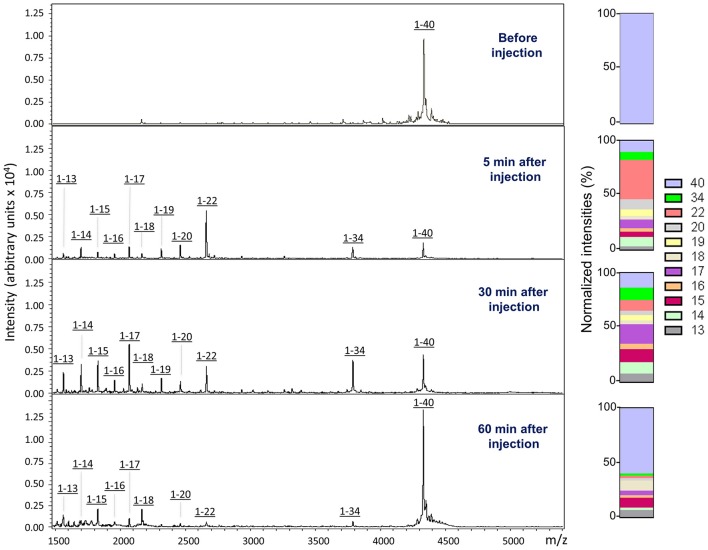
Aβ species cleared to the CSF assessed by a combination of immunoprecipitation and mass spectrometry. MALDI-ToF spectra and normalized ion counts of the monomeric Aβ1-40 used for the experiments prior injection (top). MS profile of the material immunoprecipitated from CSF at different time points (5, 30, and 60 min) post injection identify multiple C-terminally degraded proteolytic fragments. Immunoprecititation was performed in pooled CSF samples from 4 mice injected under the same experimental conditions in 2 independent experiments (n = 8) and spotted in duplicate in the mass spectrometer aluminum plates.